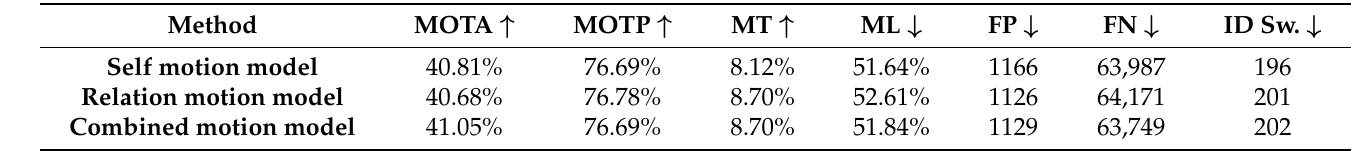
Table 5. Comparison of multi-object tracking performance with self motion, relation motion, and com- bined motion